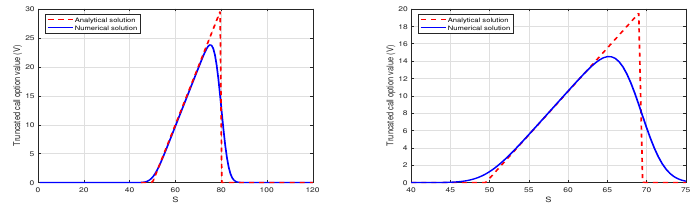
Figure 10. Poor performance of the MMADE scheme if one of the conditions (29) or (30) is vio- lated. Example with parameter values r = 0.07, σ = 0.001, a = − 8800, T = 0.01, U = 80, K = 50, L = 20, S max = 120, ∆ S = 0.75, ∆ t = 10 − 4 ( left ) and Example with parameter values r = 0.01, σ = 0.001, a = − 1250, T = 1, U = 70, K = 50, L = 30, S max = 140, ∆ S = 0.5, ∆ t = 10 − 3 ( right ).